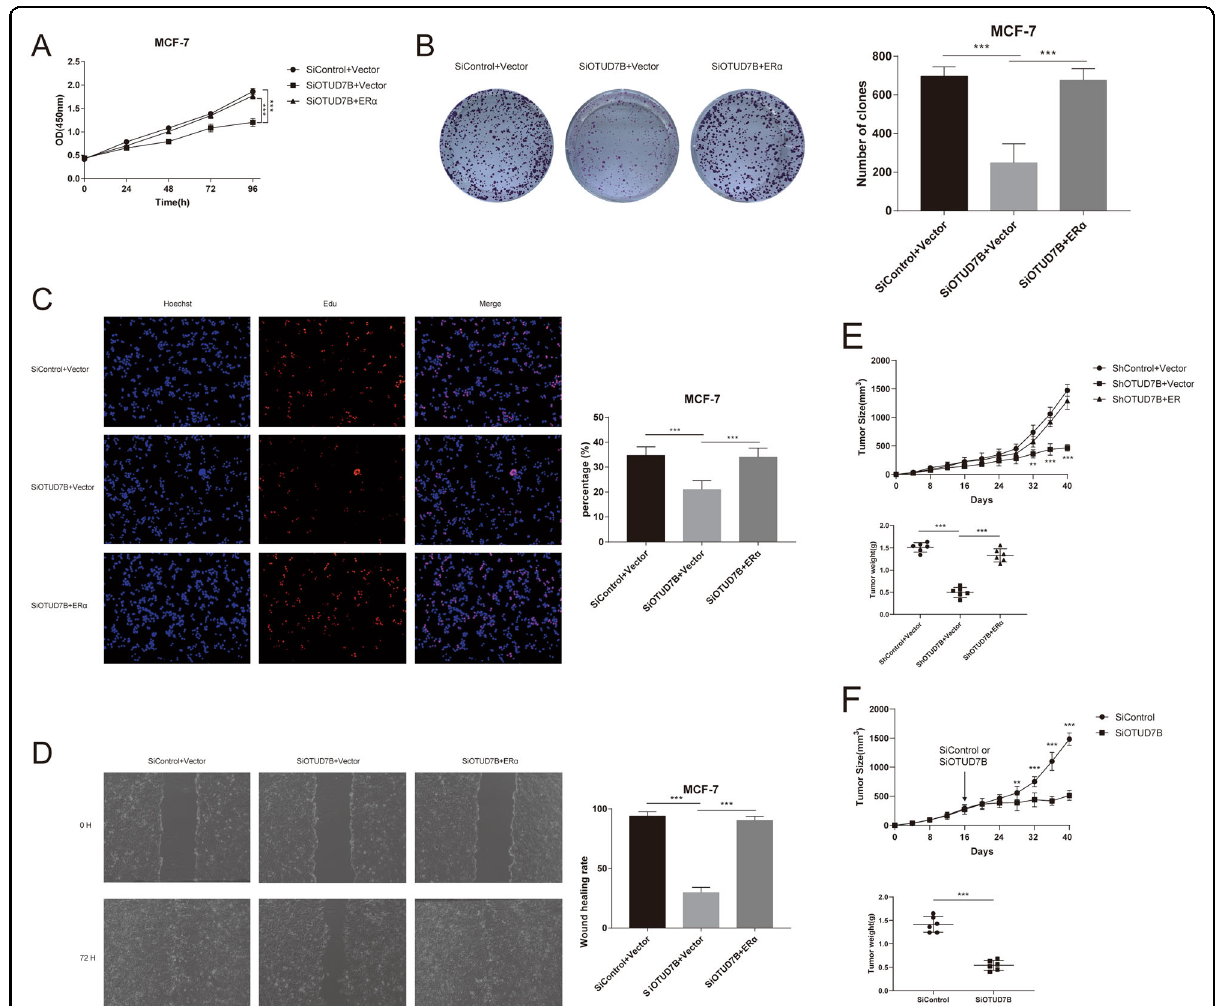
Fig. 8 Increased ER α expression reverses the effect of OTUD7B depletion. A Cell proliferation assay of MCF-7. B Clone formation assay of MCF-7. C Representative images of EdU assay of breast cancer cells. D Wound-healing assay of MCF-7. E Overexpression of ER α in OTUD7B-knockdown cells recovered tumor growth in vivo. F In total 2 × 10 6 MCF-7 cells were injected into the mammary fat pad of female BALB/c nude mice. When the tumor had grown to an appropriate volume (200 mm 3 ), the tumor-bearing mice were randomly divided into groups. Cholesterol-modi fi ed OTUD7B siRNA or control siRNA (Ribobio, 10 nmol/kg) dissolved in diluted water were intratumorally injected every 3 days until the end of the experiment. * P value < 0.05, ** P value < 0.01, *** P value <